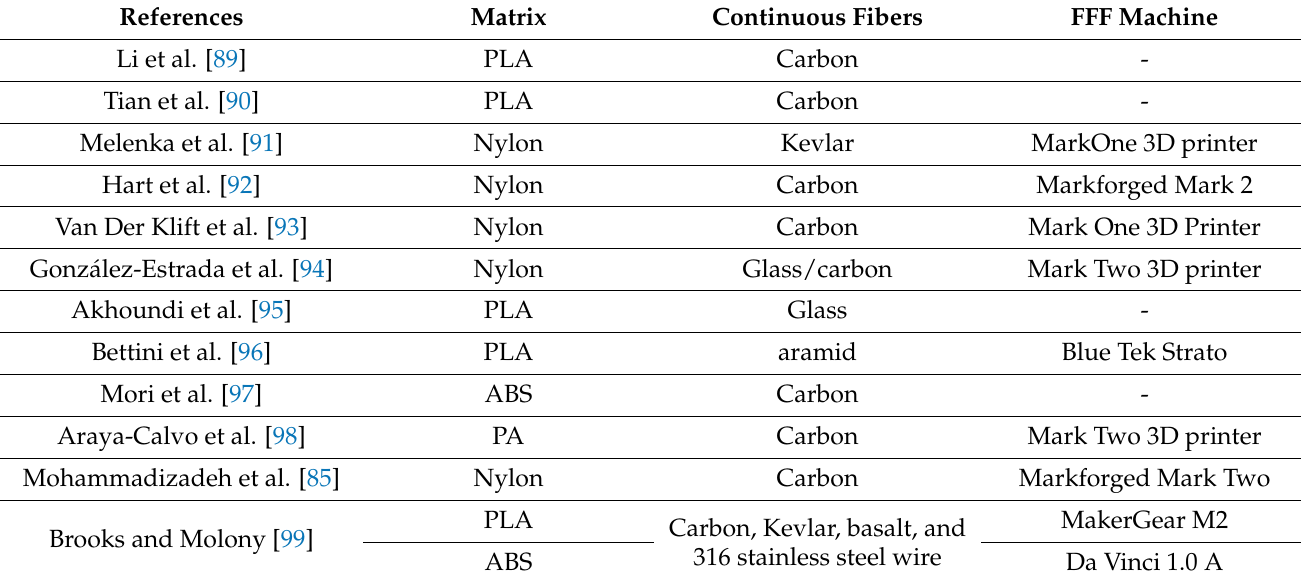
Table 6. Continuous fiber composites for filaments. ABS—acrylonitrile butadiene styrene, PLA—polylactic Acid,